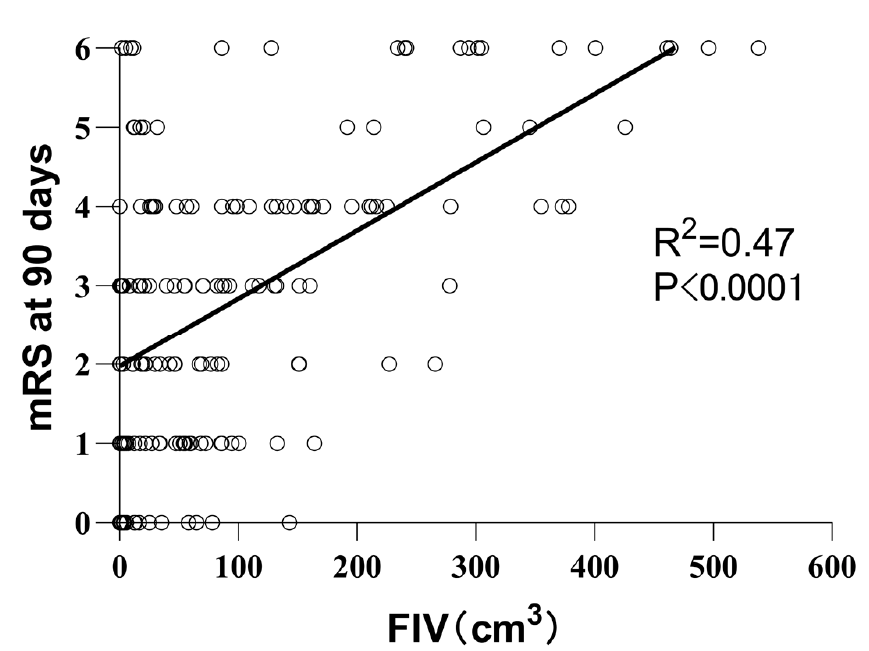
Figure 2. The line chart of Spearman’s rank correlation results between FIV and mRS at 90 days; FIV = follow‑up infarct volume at 3–7 days. Each circle represents a patient. Table 3. Uni- and multi-variate analysis using the linear mixed effect model for FIV.